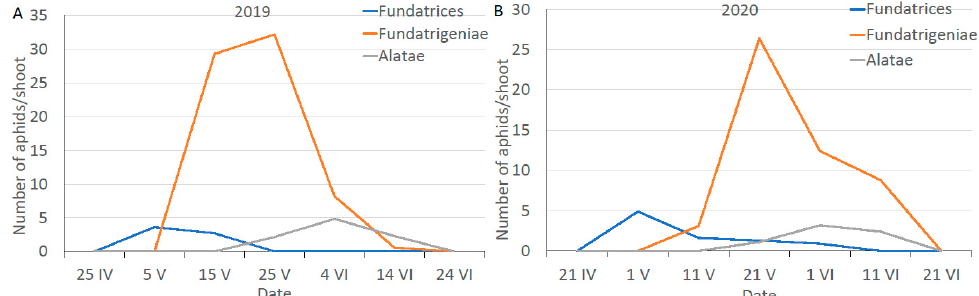
Figure 1. The dynamics of three morphs of the A. fabae population on its primary host in the spring periods of 2019 ( A ) and 2020 ( B ) .